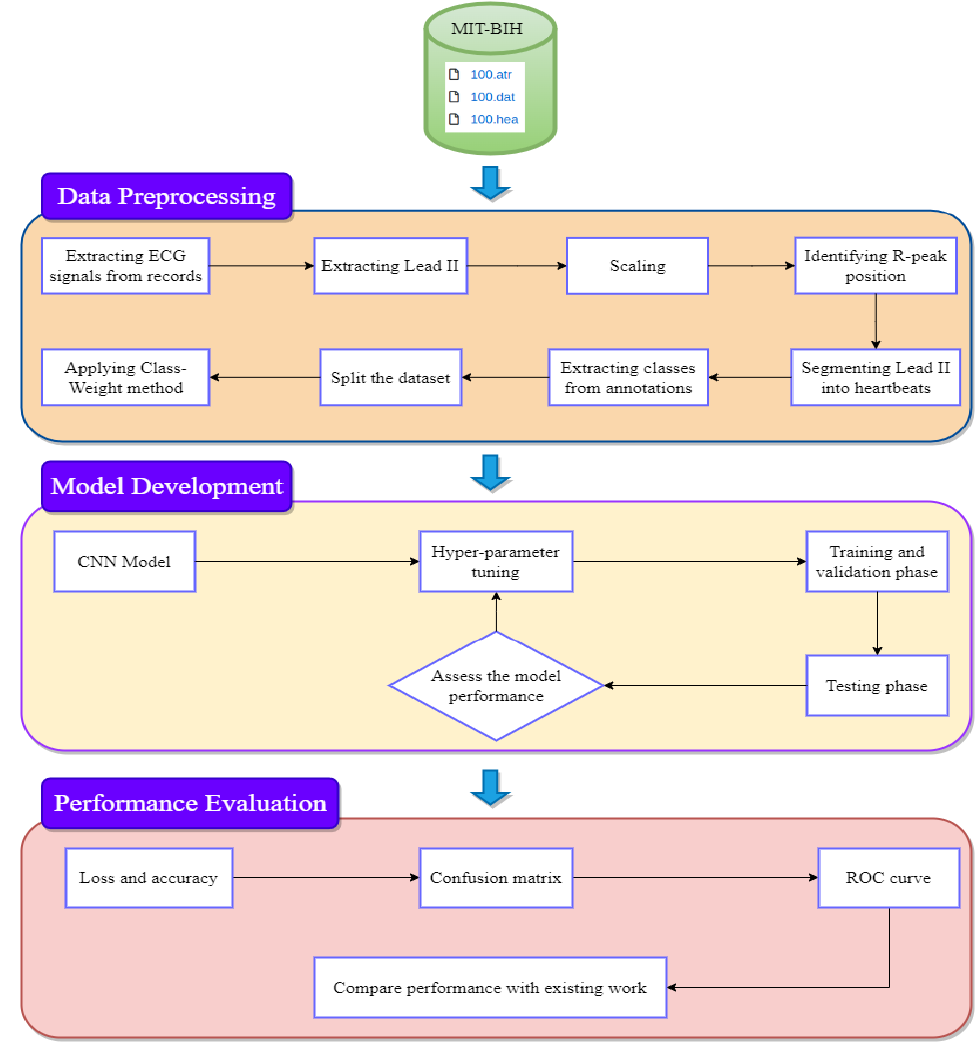
Figure 2. The proposed classification of cardiac arrhythmias based on 1D-CNN model.